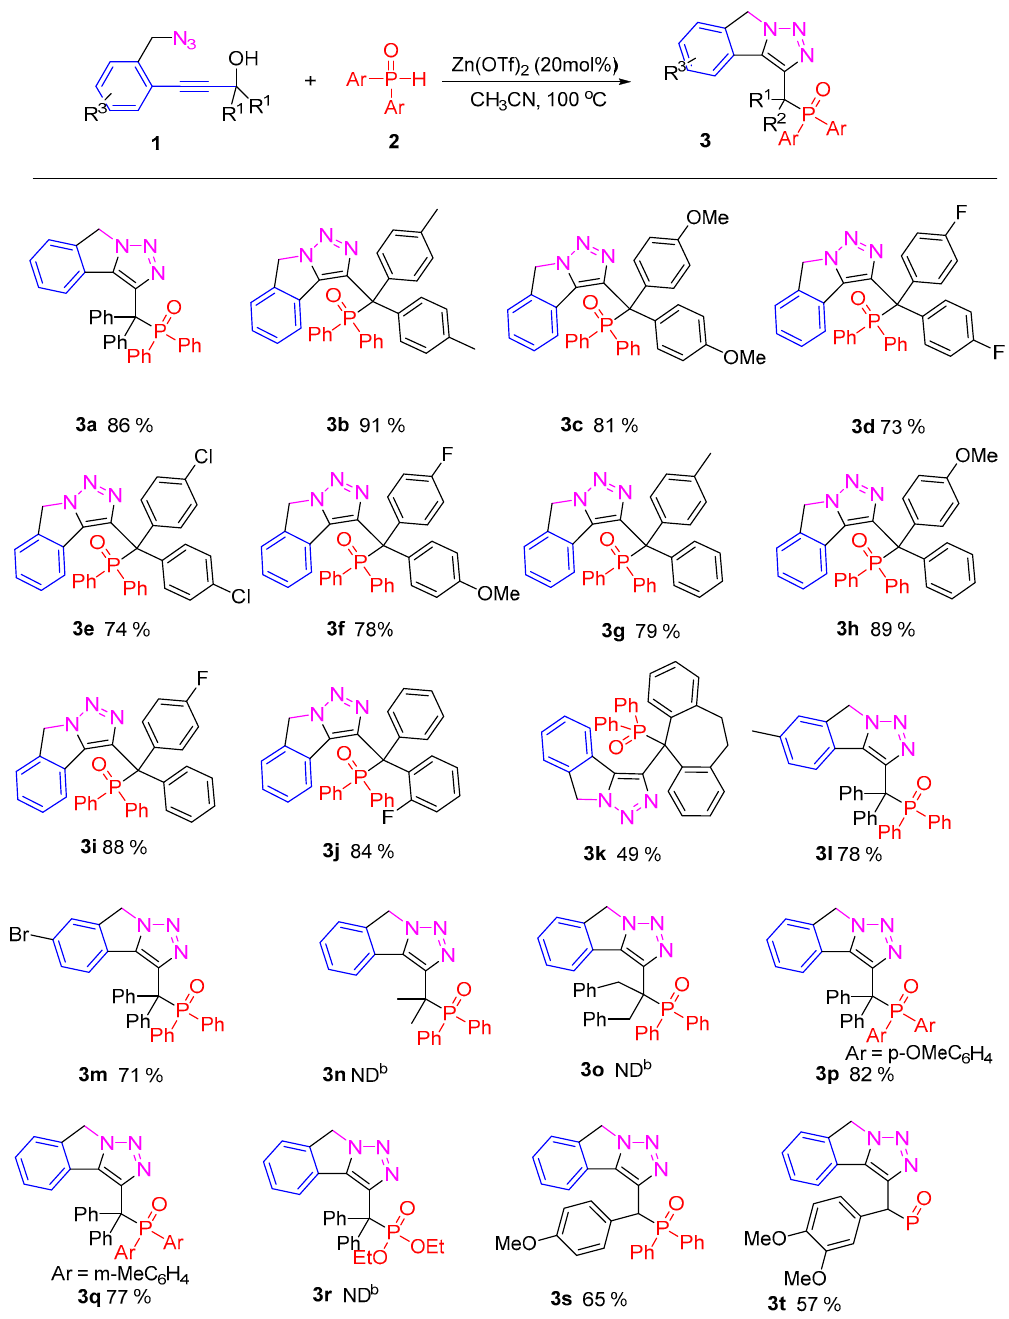
Figure 2. Transformation of propargylic alcohols 1 to phosphorylated isoindoine fused with trizoles 3 a . .a Unless otherwise noted, all reactions were performed with 1 (0.2 mmol) in CH 3 CN (2.0 mL) at 100 °C for 1 h. Isolated yield. b The corresponding product cannot be detected by TLC.